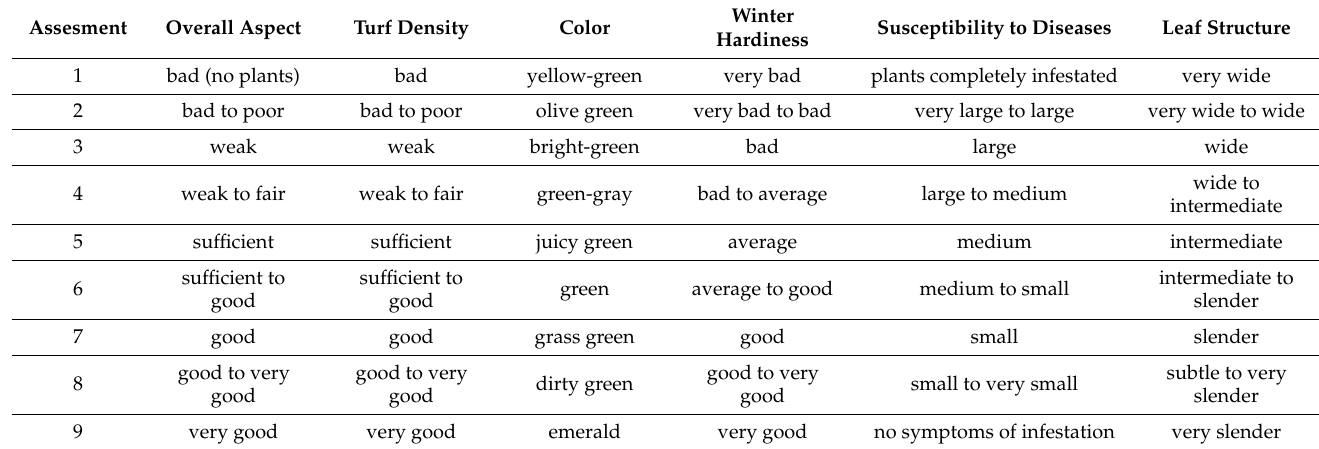
Table 3. Scale grades used for bonitation assessment of turf quality .